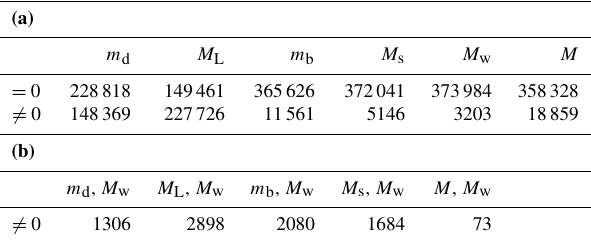
Table 2. (a) Number of magnitudes with zero and non-zero values between 1964 and 2018 in the catalogue. (b) The number of mag- nitude pairs with non-zero